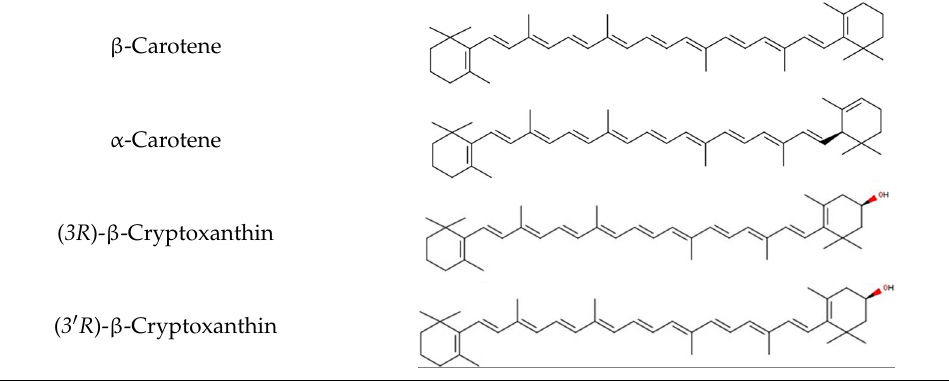
Table 1. Structural formulae of carotenoids that were analyzed.